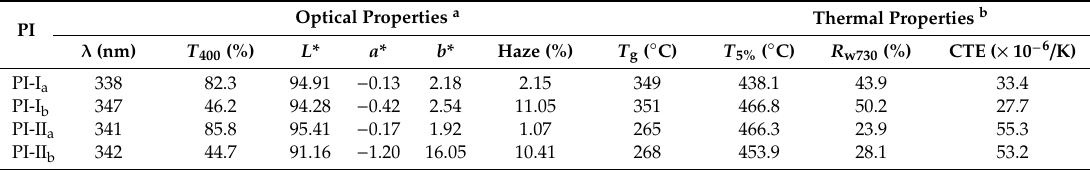
Figure 7. Thickness–transmittance relationship of PI-I a film.